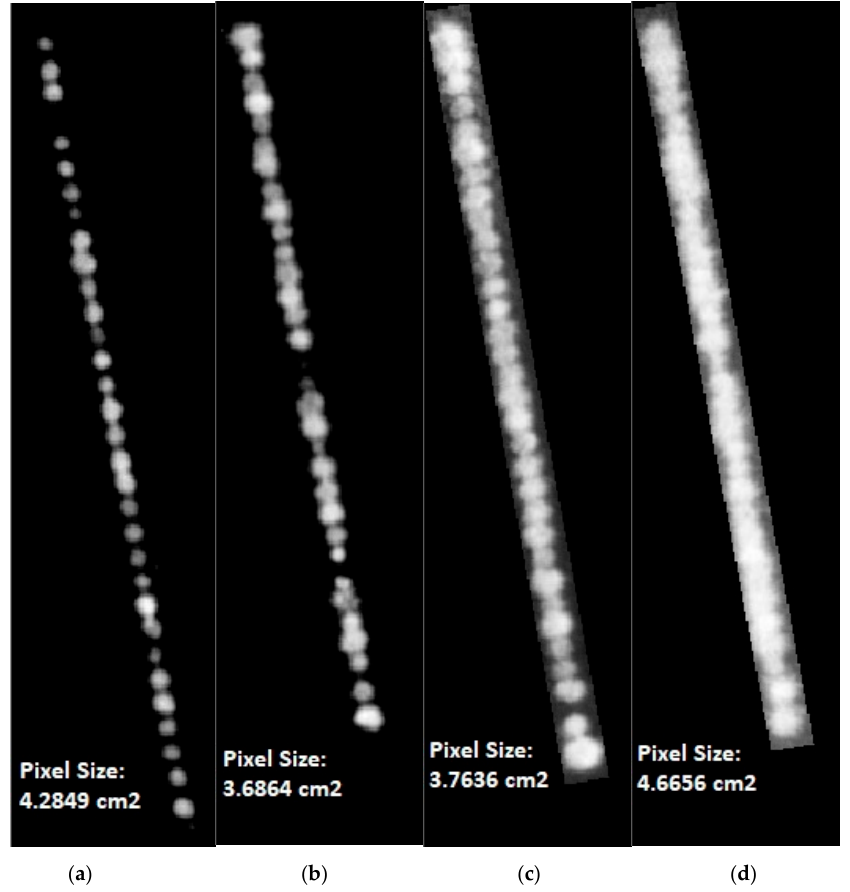
Figure 5. ( a – d ) A small set of different crop rows extracted from four field trial images taken on ( a ) 9 May 2017, ( b ) 5 July 2017, ( c ) 11 September 2017 and ( d ) 20 November 2017. Note: that the rows at different time points are not exactly the same length as pixel size varied slightly from expected 2 cm. Values were converted to metric units to standardize between capture dates.